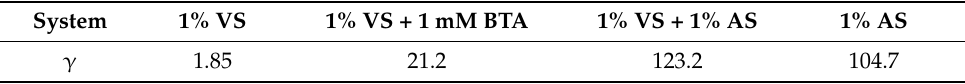
Table 6. Values of corrosion inhibition coefficients of steel with modifying